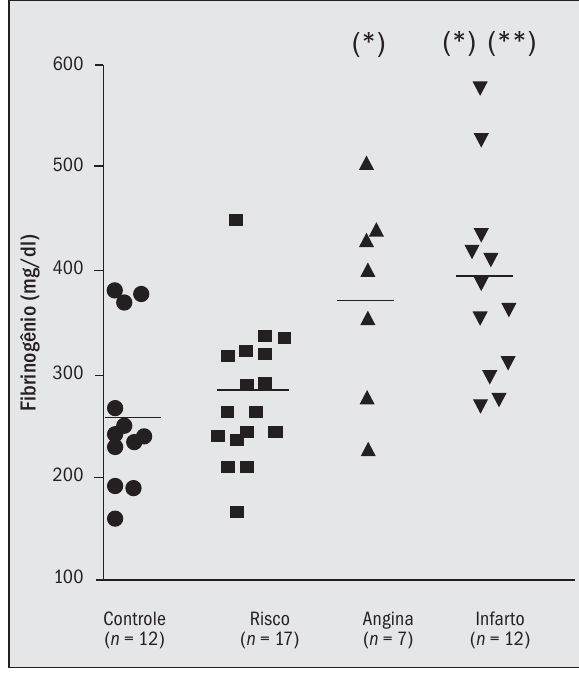
Figura 1 – Resultados das determinações dos níveis de fibrinogênio nos grupos estudados ( n = número de amostras). As barras horizontais indicam os valores médios de cada grupo. (*) Indica diferença significativa do grupo-controle em relação aos grupos angina e infarto ( p < 0,05). (**) Indica diferença significativa entre o grupo de risco e o grupo infarto ( p <